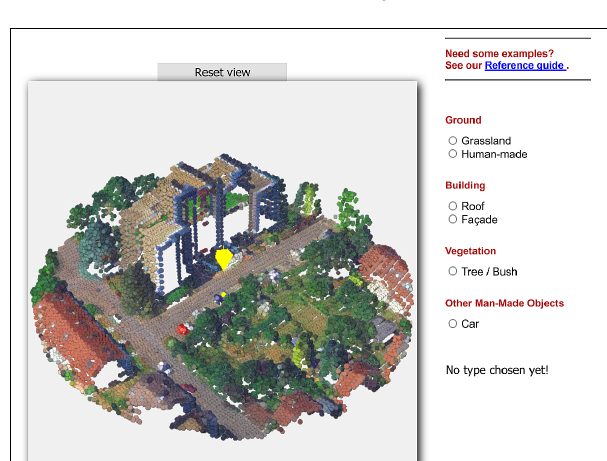
job. Furthermore the first point to be checked is a control point which is repeated as last point in order to check consistency of the answers. Therefore, every job requires 13